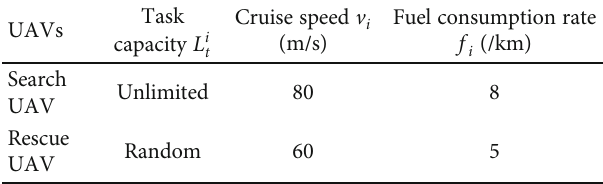
Figure 3: ATS-UT. Table 2: Simulation parameters of UAVs.